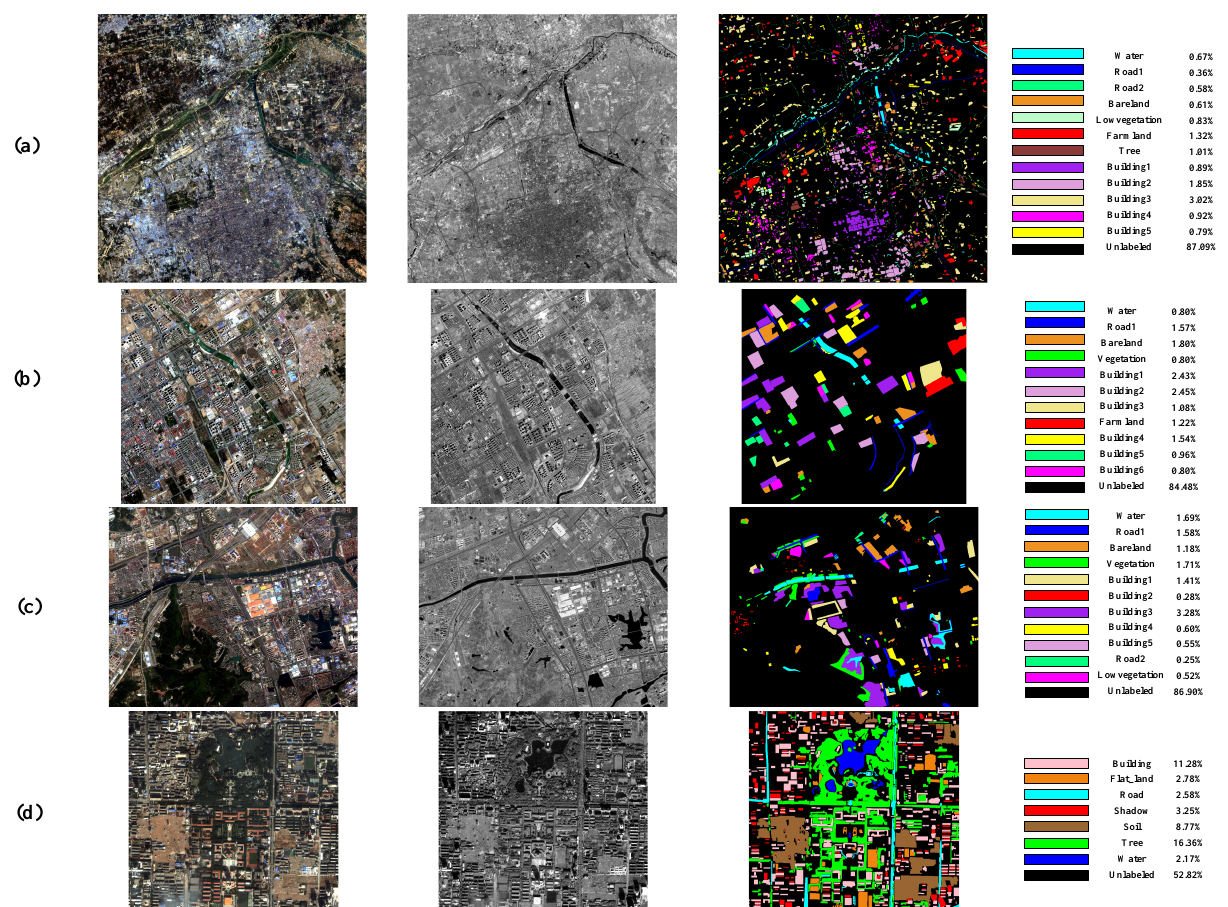
Figure 6. First column: MS image. Second column: PAN images (The PAN image is reduced to the same size as their MS image for a more convenient display). Third column: Ground truth image. Last column: The class labels corresponding to the ground truth image. ( a ) Xi’an Level 1A image set (4548 × 4541 pixels). ( b ) Huhehaote Level 1A image set (2001 × 2101 pixels). ( c ) Nanjing Level 1A image set (2000 × 2500 pixels). ( d ) Xi’an Ubarn image set (800 × 830